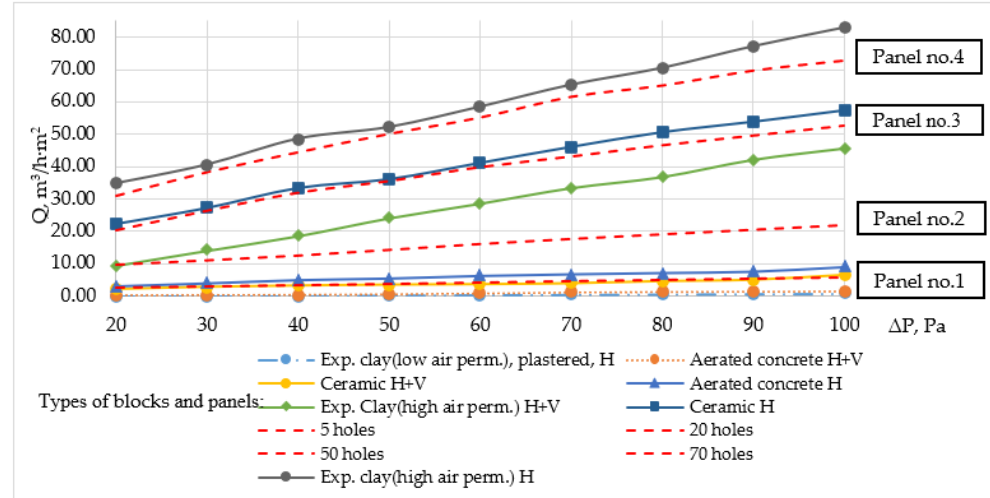
Figure 3. Air permeability measurement results of various block masonry wall samples and drilled wood fiber cement